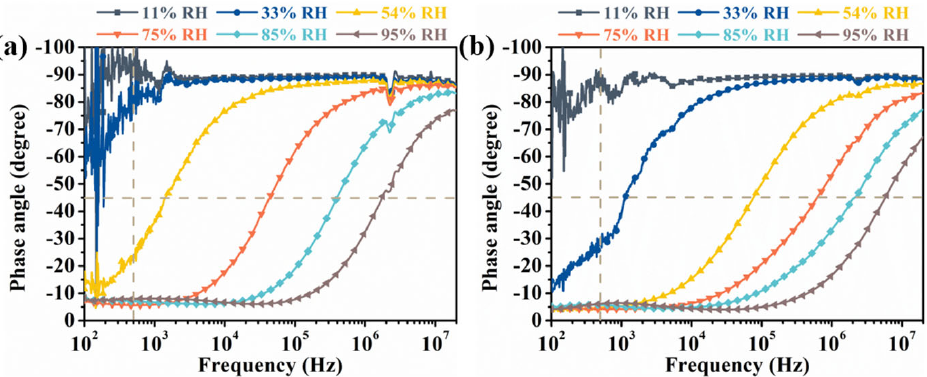
Figure 7. The phase angles of ( a ) blank CNFs sensor and ( b ) CIL@CL − 2